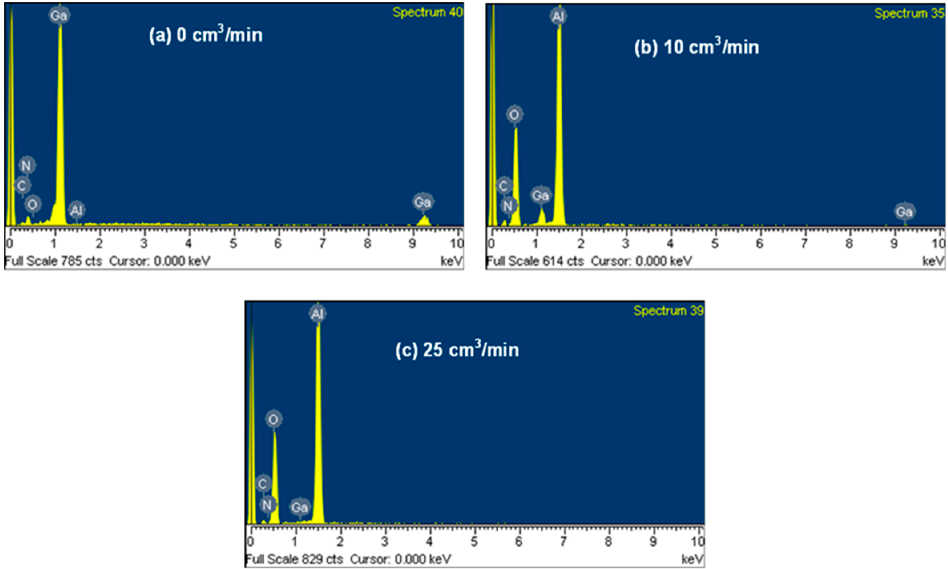
Figure 2. Scanning electron microscopy–energy dispersive spectrometer (SEM–EDS) spectra of the GaN-epi/PSSs decomposed at 1200 °C for 3 h under hydrogen flow rates of ( a ) 0 cm 3 /min, ( b ) 10 cm 3 /min, and ( c ) 25 cm 3 /min.